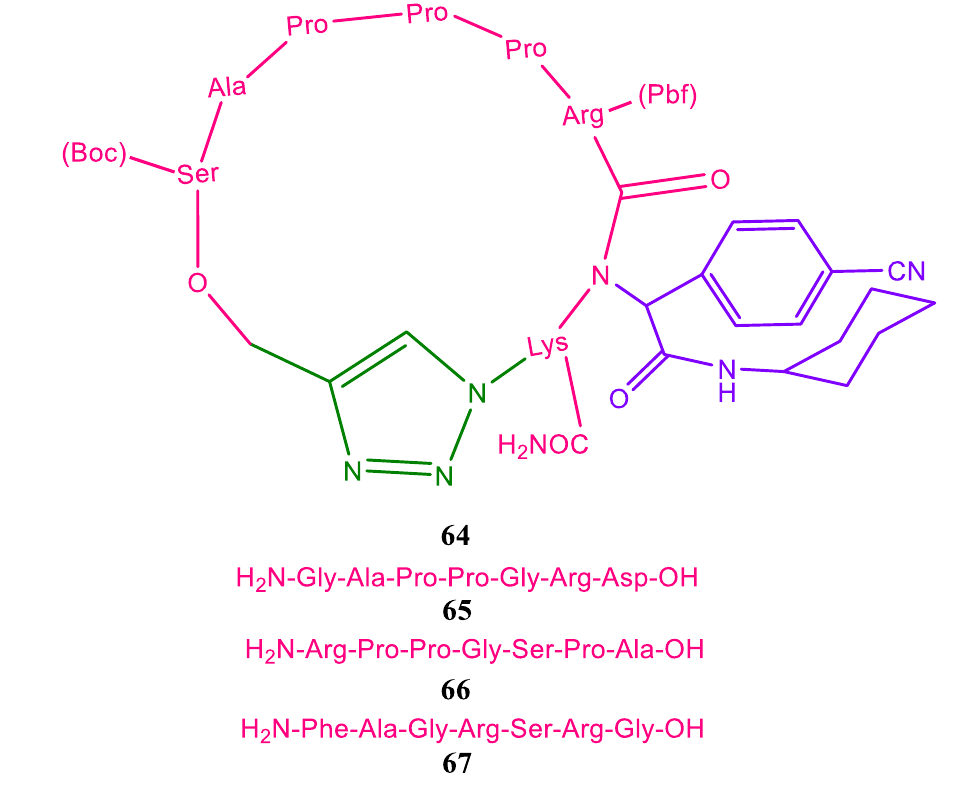
Figure 55. Triazole conjugated cycloheptapeptides.